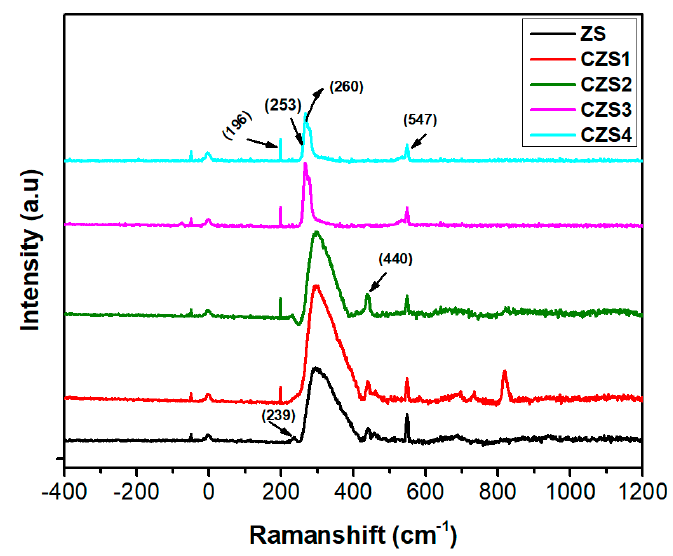
Figure 6. Raman spectra of the undoped and Cu -doped ZnSe